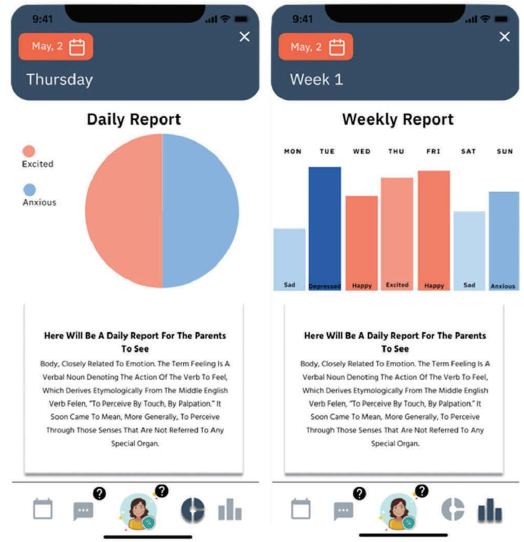
Figure 6: Representation of daily and weekly emotion